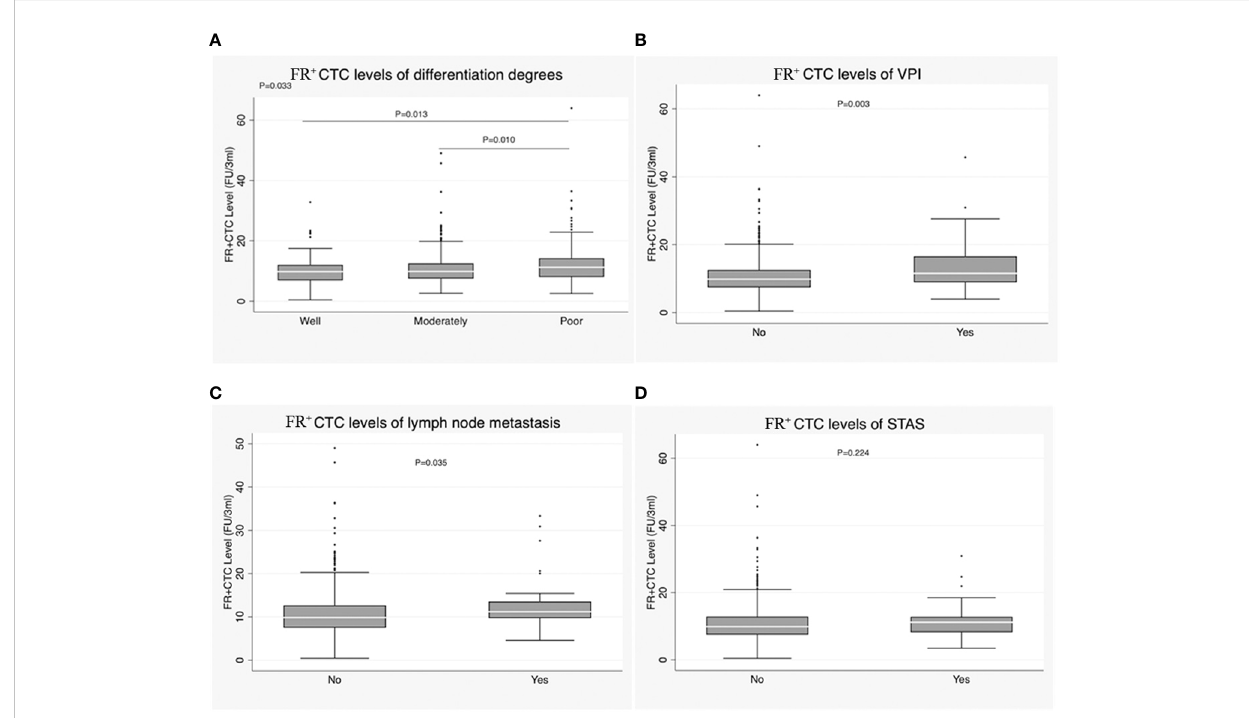
FIGURE 4 (A) Correlation of FR + CTC level with degree of differentiation in the IAC group. (B) Correlation of FR + CTC level with visceral pleural invasion (VPI) in the IAC group. (C) Correlation of FR + CTC level with lymph node metastasis in the IAC group. (D) Correlation of FR + CTC level with STAS in the IAC